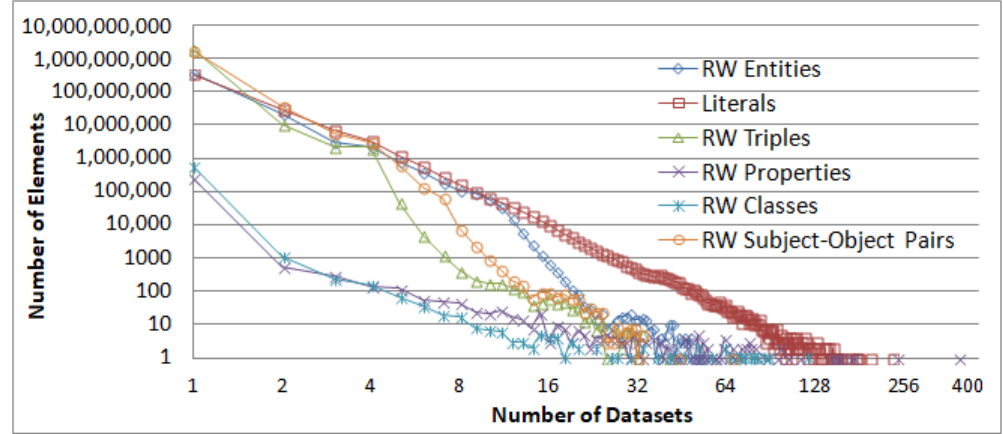
Figure 4. Number of datasets where different sets of elements